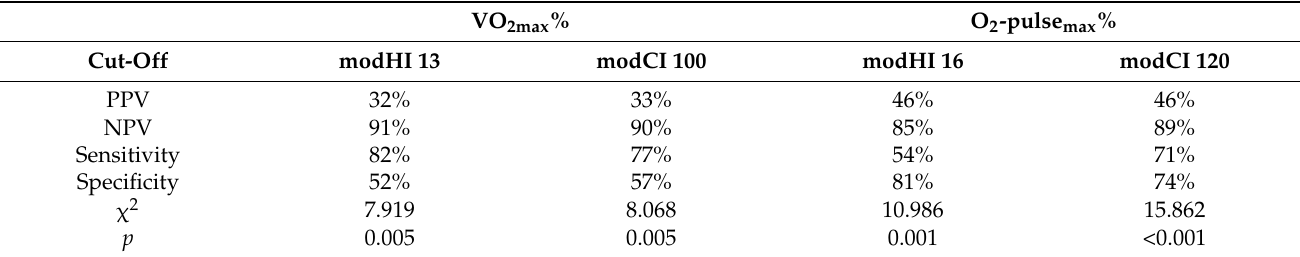
Table 2. Results of contingency tables to detect impaired cardiopulmonary